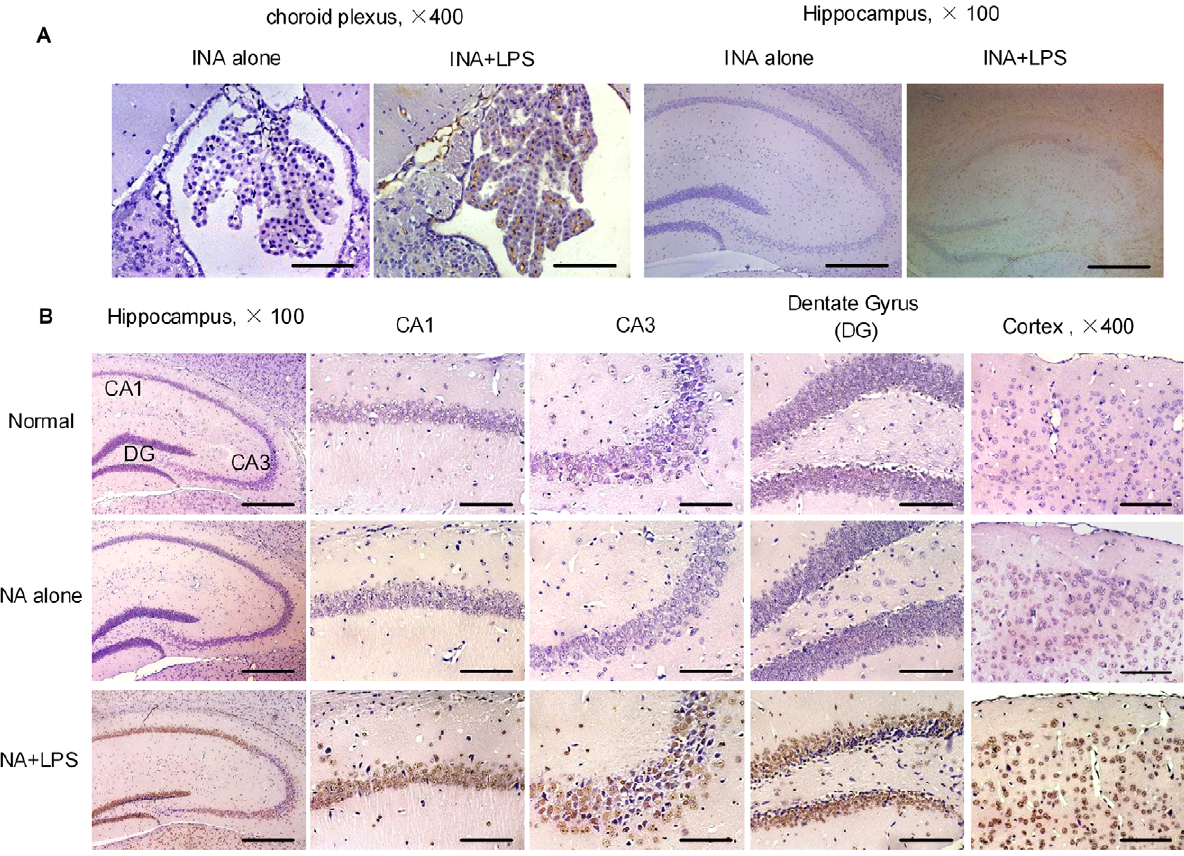
Figure 5. INA immunized plus LPS treated mice exhibited hippocampus and cortex neuron apoptosis. (A) IgG deposition at the choroid plexus (left) and hippocampus (right) in different groups of mice. (B) CA1, CA3 and dentate gyrus regions of hippocampal, and cortex areas from indicated group of mice. TUNEL staining demonstrated neuron apoptosis. ( 6 400, Bar =50 m m; 6 100, Bar =200 m m).